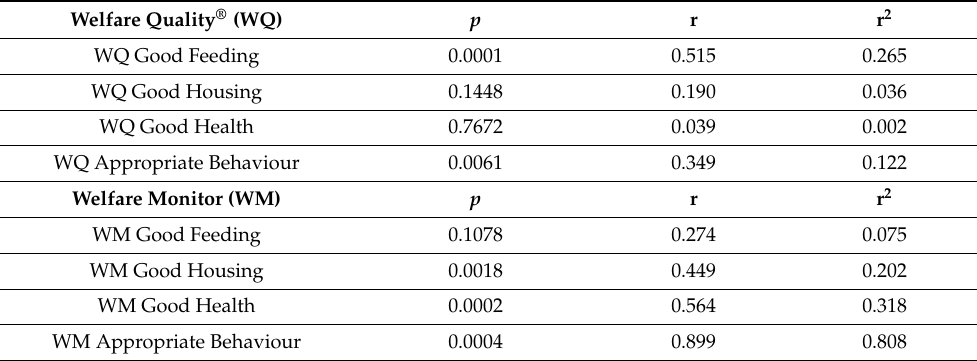
Table 4. Correlations of the principle scores with the end classification of WQ and the new Wel- fare Monitor.